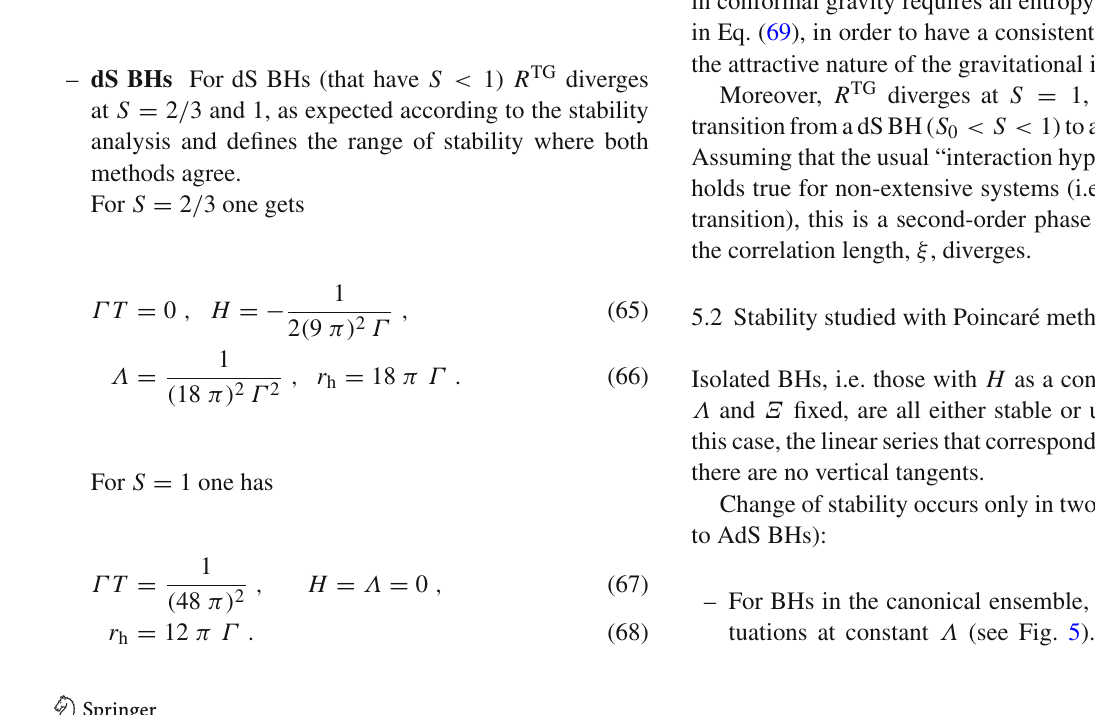
Fig. 4 R TG as a function of S . The dotted line refers to the range where gravitational interaction has a repulsive behavior, according to TG, hence we exclude it